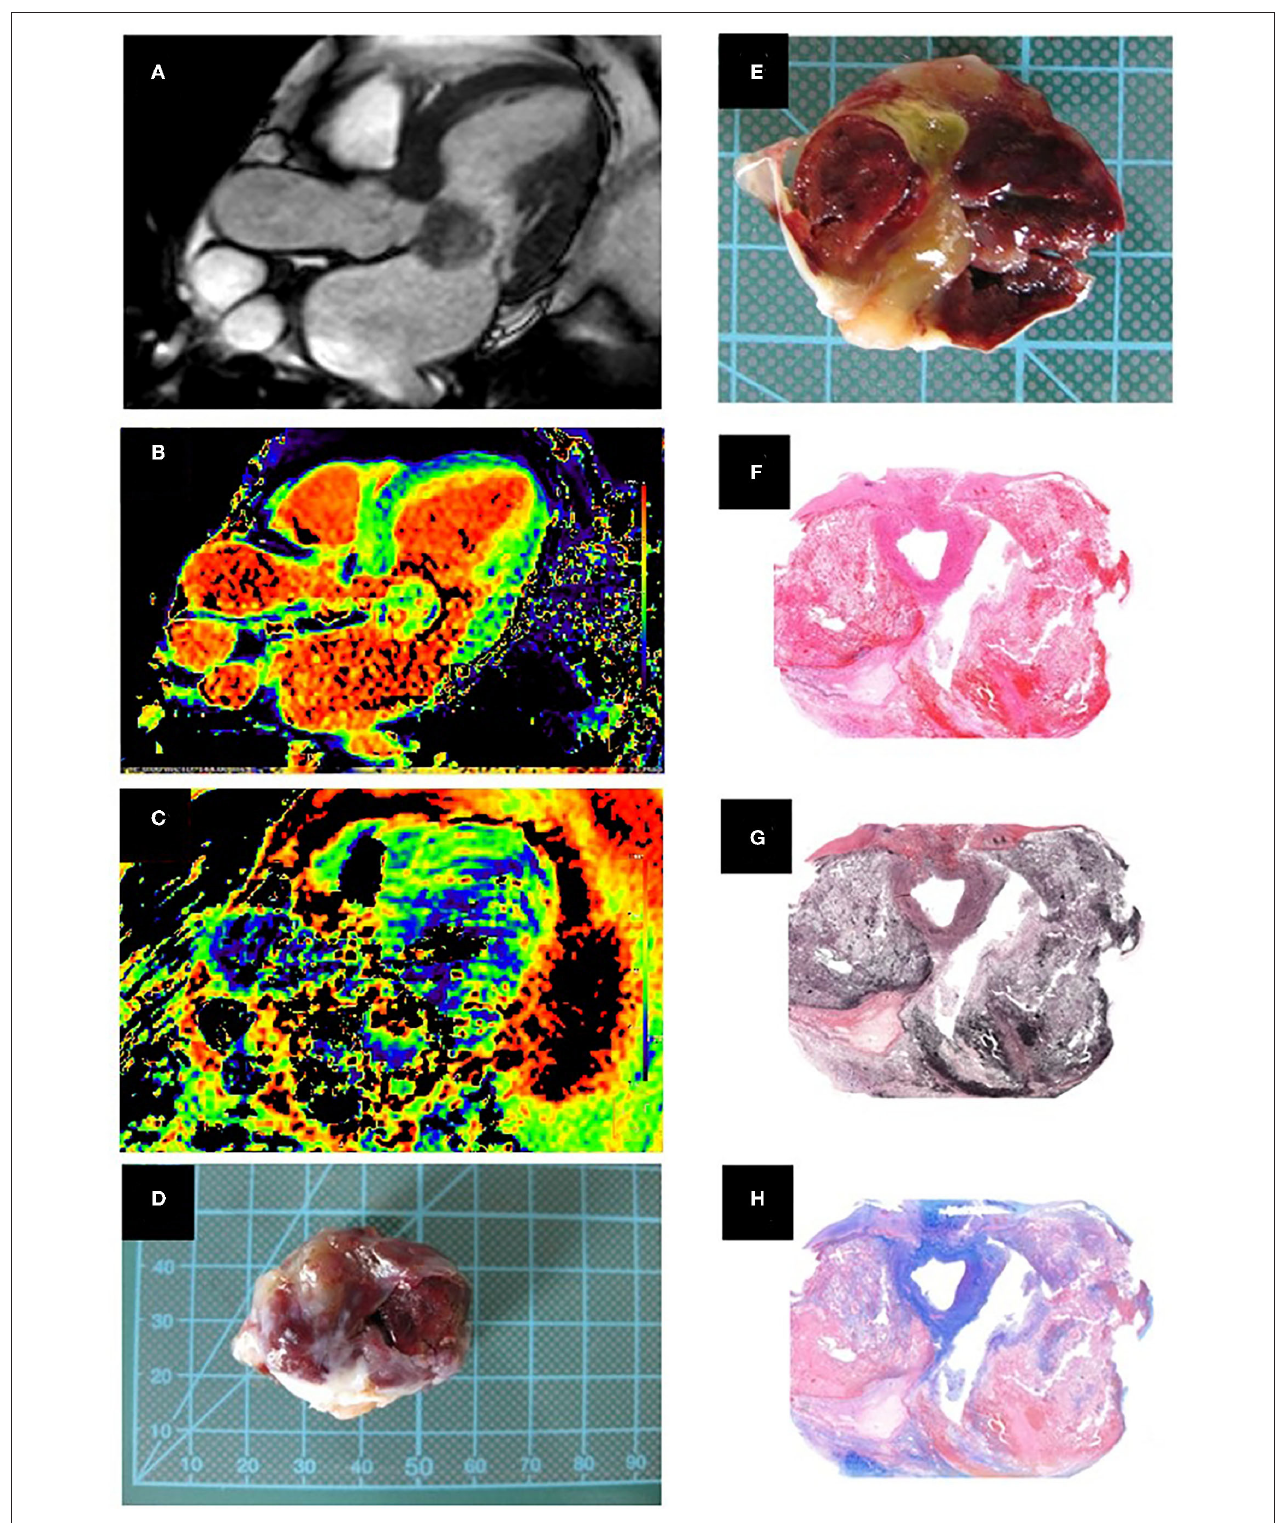
FIGURE 3 | (Case 3). (A) Cine image, three chamber view showing the cardiac myxoma attached to the anterior mitral leaflet where the inhomogeneous nature can be appreciated. (B) Native T1 relaxation time mapping (C) T2 relaxation time mapping. (D) Macroscopic appearance of the smooth surfaced resected mass. (E) Cut surface of the mass with old and recent hemorrhages and cystic changes in the central portion. Histopathology, low magnification. (F) Hematoxylin/eosin stained